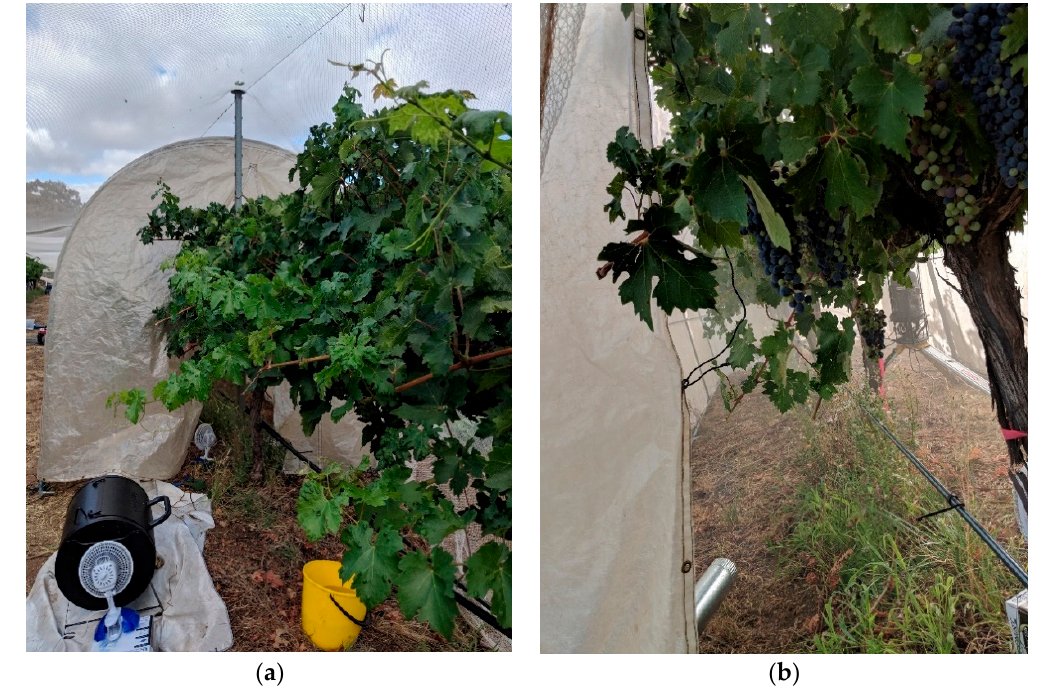
Figure 1. Smoke treatments were applied to grapevines using a purpose-built smoke tent;